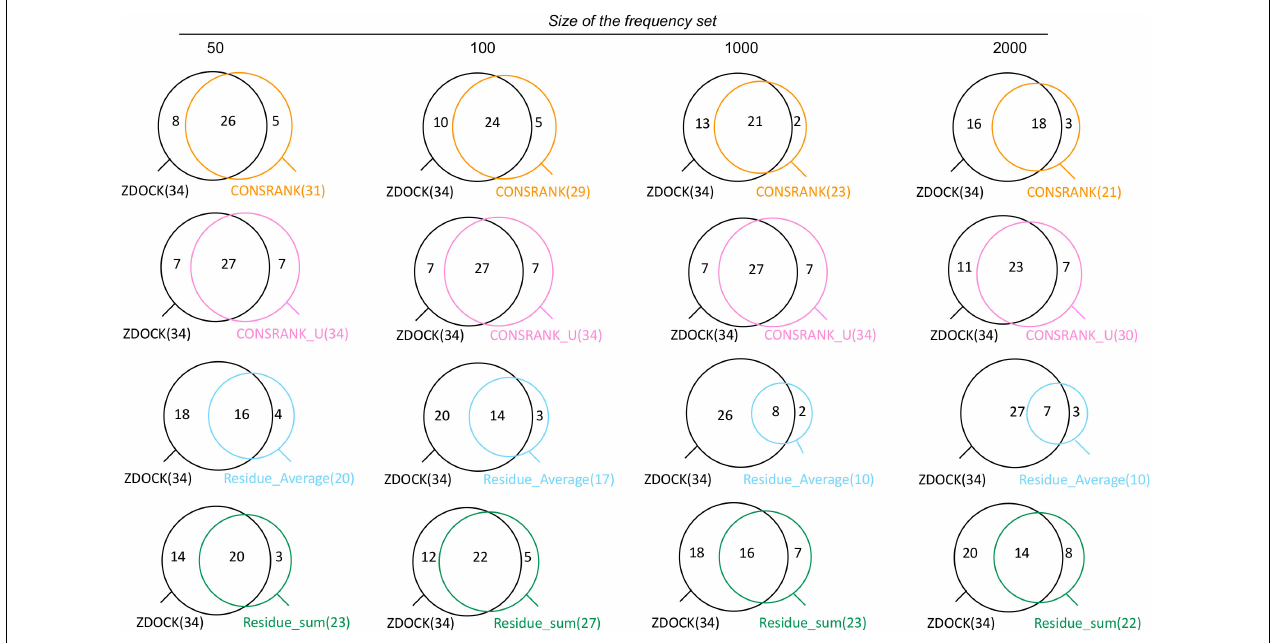
FIGURE 2 | Venn diagrams showing the overlap between successful cases with the ZDOCK native scoring function and each of the rescoring functions, when using structural clustering.